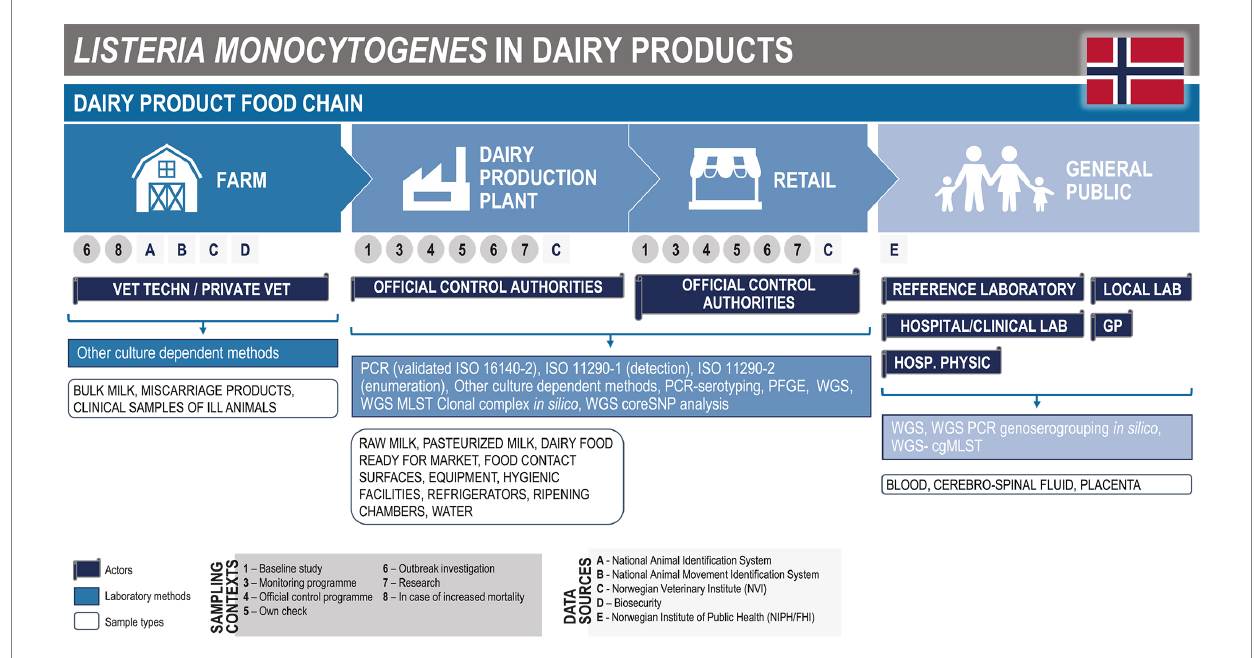
FIGURE 2 Listeria monocytogenes mapping. Modified with permission from Cito et al., 2022